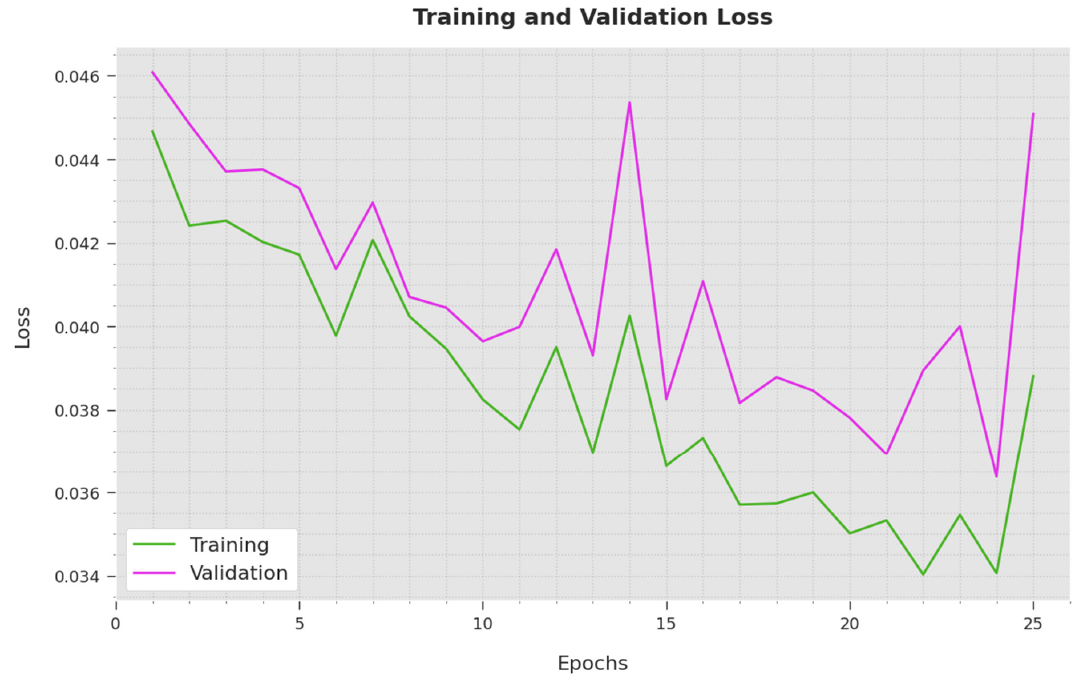
Figure 7. TL and VL analysis of ODAE ‐ WPDC approach.